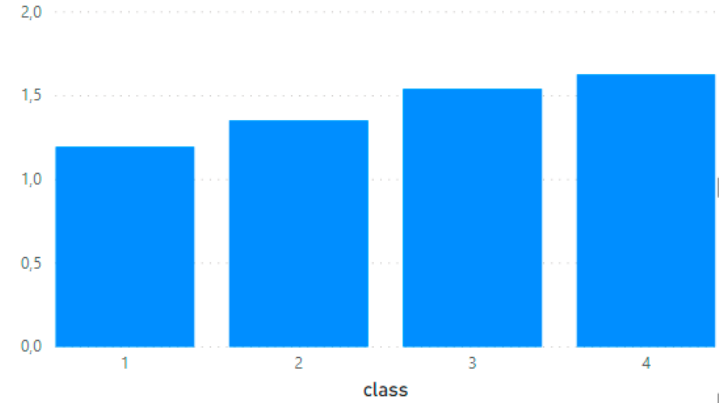
Figure 12. Rate of occupancy by household according to social class.